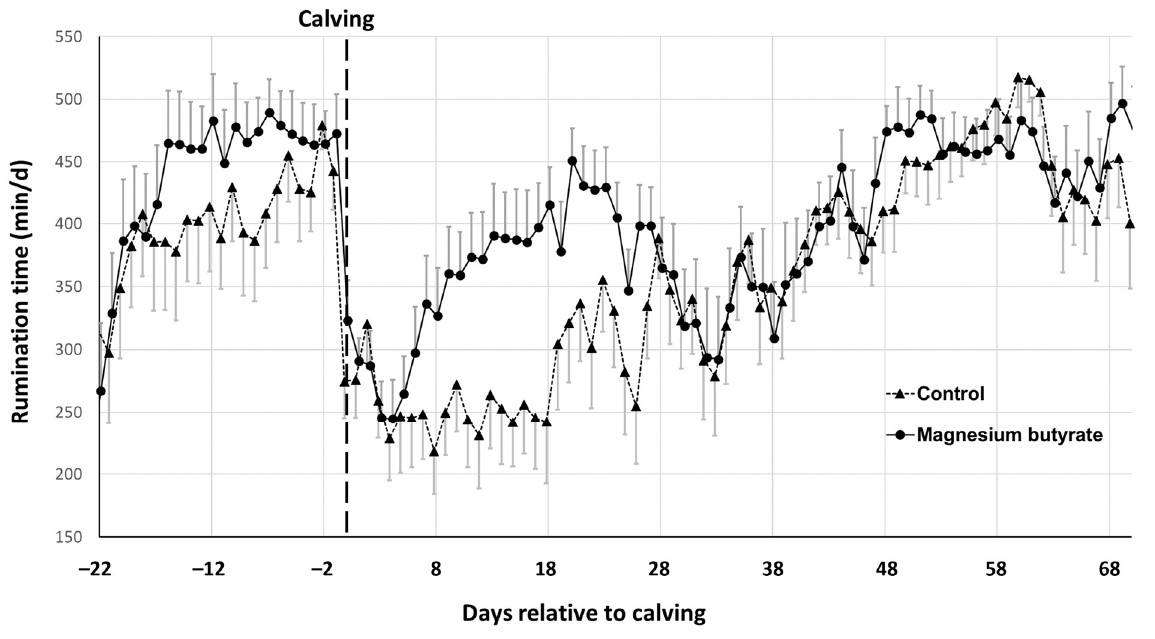
Figure 2. Daily rumination time from 22 days before calving to 70 days in milk of dairy cows with (MgB, n = 34) and without (Control, n = 31) prepartum magnesium butyrate supplementation. Data are presented as daily average means ± SD.